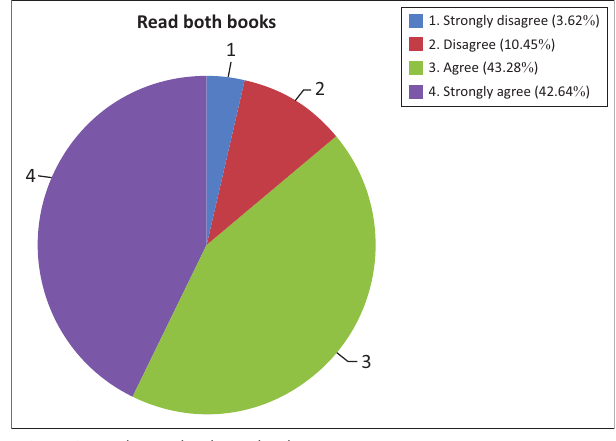
FIGURE 2: Read every book at school.